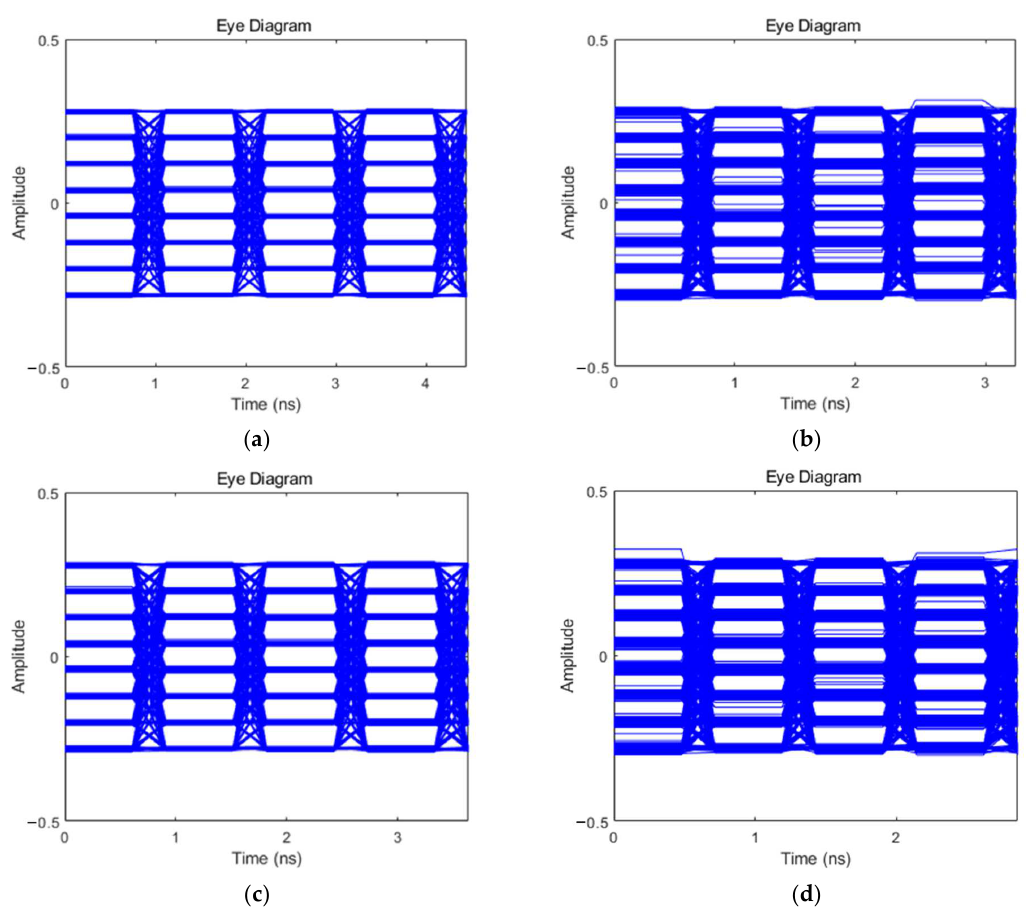
Figure 17. Simulated eye diagrams of PAM-8 signal with RBF-NN as post-equalizer: ( a ) communi- cation data rate of 2.7 Gbps with 3 m free-space channel; ( b ) communication data rate of 3.6 Gbps with 3 m free-space channel; ( c ) communication data rate of 3.3 Gbps with 1.2 m underwater channel; ( d ) communication data rate of 4.2 Gbps with 1.2 m underwater channel.